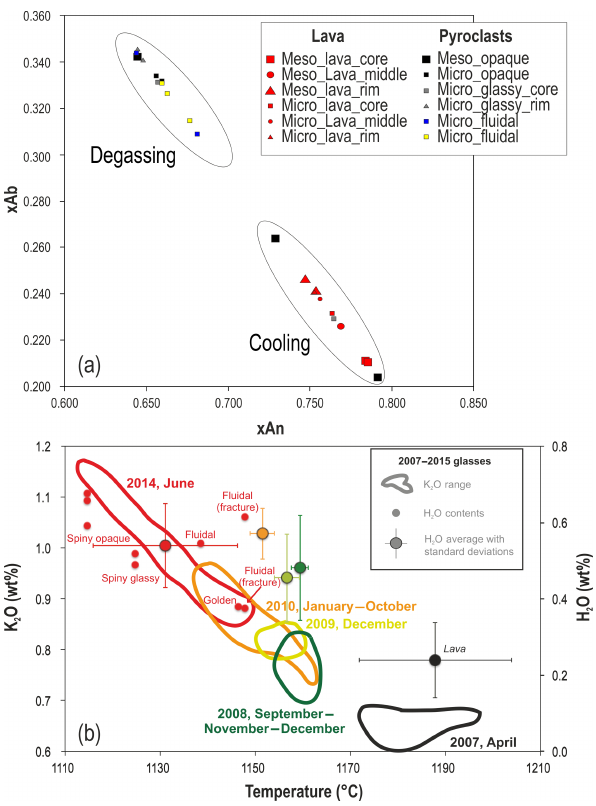
Figure 10. (a) Anorthite versus albite compositions for the plagio- clase crystals measured for the June 2014 eruption of PdF. (b) Tem- perature, composition (K 2 O), and dissolved water content (H 2 O) for the evolution of 2007–2014 melts from glasses. The data have been obtained by studying the glass–plagioclase equilibrium or on the basis of matrix glass analyses. Temperature estimation based on the MgO thermometer of Helz and Thornber (1987) modified by Putirka (2008). Water content is from the plagioclase hygrometer of Lange et al. (2009). Only plagioclases in equilibrium with melts are considered, following the procedure described by Putirka (2008) for >1050 ◦ C melts (Kd = 0.27 ± 0.05). Error bars reported in Fig. 10b correspond to the standard deviation of the plagioclase dataset, whose range is larger than the error of the method. We stress that the reported temperatures are obtained using the Helz dry model. Fur- ther uncertainty arises from the dependence of the method on dis- solved water content as shown recently by Putirka (2008). In order to minimize the number of assumptions and perform a comparison between distinct eruptions, we preferred the dry